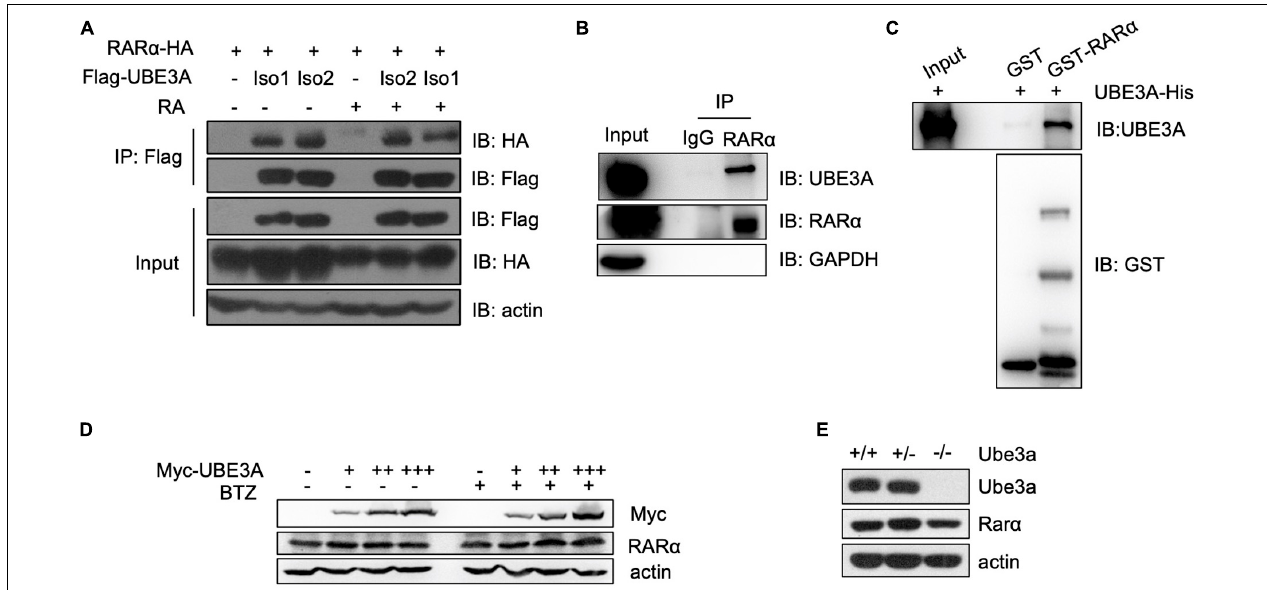
FIGURE 3 | UBE3A directly interacts with RAR α . (A,B) The interaction of UBE3A and RAR α in both endogenous and ectopically expressed HEK-293T cells. Co-immunoprecipitation (Co-IP) was performed for ectopically expressed (A) or endogenous (B) UBE3A and RAR α in HEK-293T cells treated with 1 µ M RA or DMSO for 8 h. (C) The directly interaction of UBE3A and RAR α . GST pull-down assays were performed with GST or GST-RAR α and UBE3A-His. (D,E) Endogenous RAR α (D) or Rar α (E) remained unchanged upon different dosages of UBE3A (D) in HEK-293T cells or Ube3a (E) protein levels in